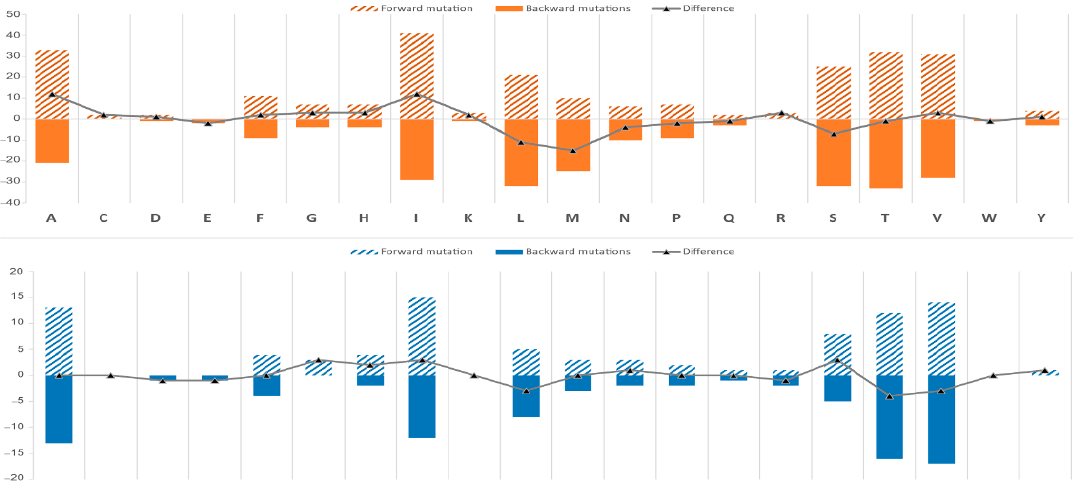
Figure 6. Observed amino acid changes in cichlid species (orange color) and haplotilapiine group (blue color). Forward mutations are labeled by pattern fill, leading to an increase in the amino acid. The backward mutations are labeled by the solid fill, leading to a decrease in the amino acid. The curved line represents the difference between forward and backward mutation. The amino acids are described with a one-letter abbreviation.